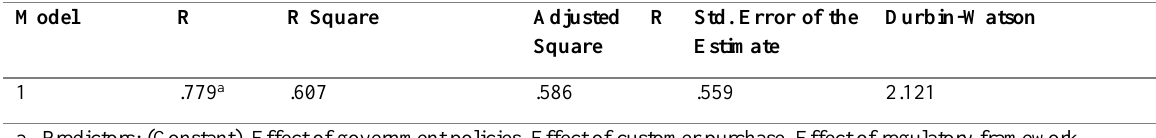
Table 4: Model Summary b